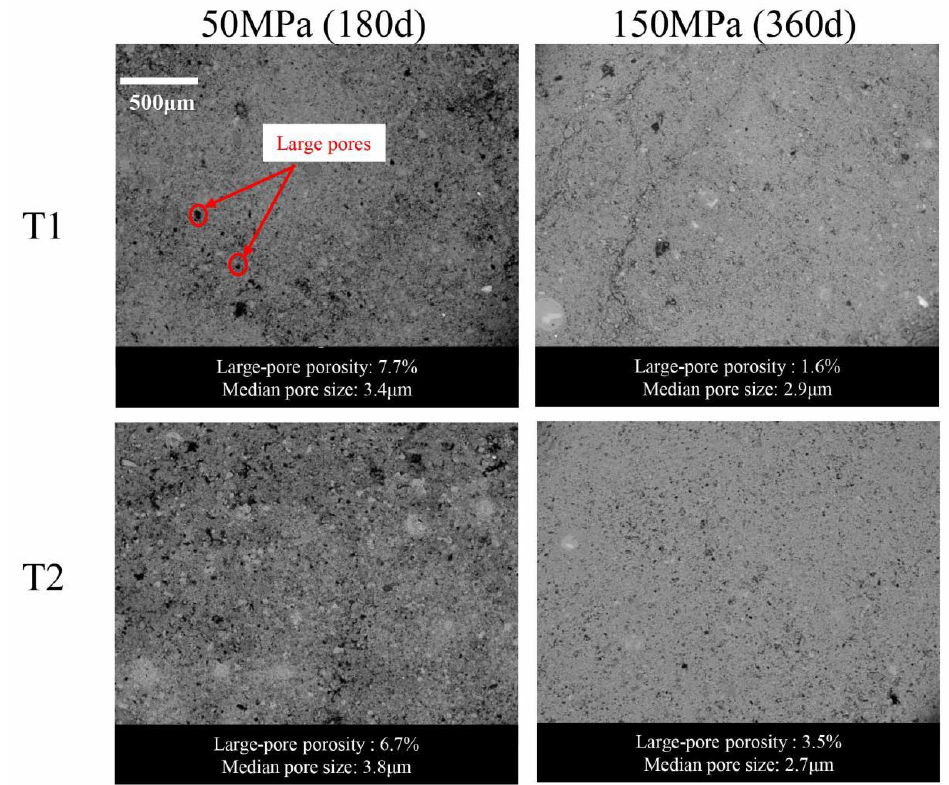
Figure 11. SEM-BSE analysis of slurries T1 and T2 showed that higher curing pressure resulted in smaller pore size and lower porosity in long-term cured